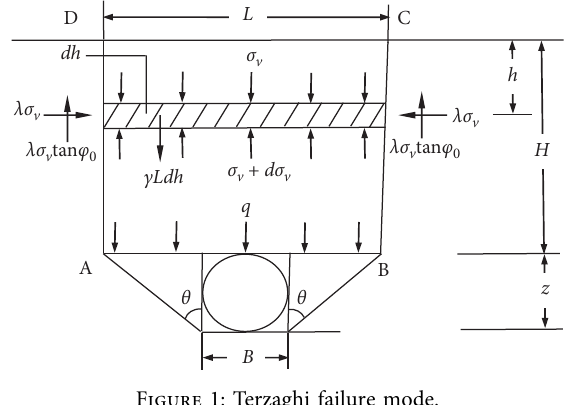
Figure 1: Terzaghi failure